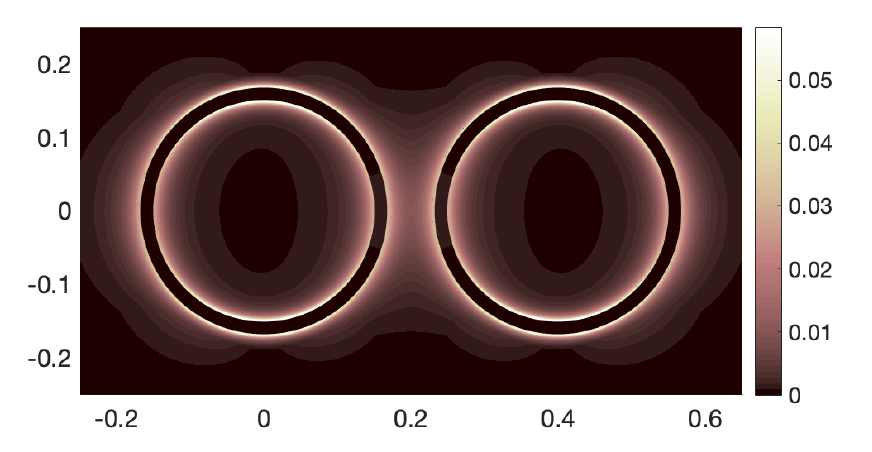
(cid:12) (cid:12) (cid:12) (cid:12) δ ( x ) − u SB ( x ) Figure 2. Plot of the difference (cid:12) u (cid:12) for x around two thin tori in the xy -plane, both subject to the constant force f = e x . Both tori have radius (cid:101) = 0.01. The maximum difference is almost exactly the same as in the single torus case, indicating that the O ( 1 ) surface discrepancy between regularized and classical SBT may not noticeably affect the flow between multiple hydrodynamically interacting